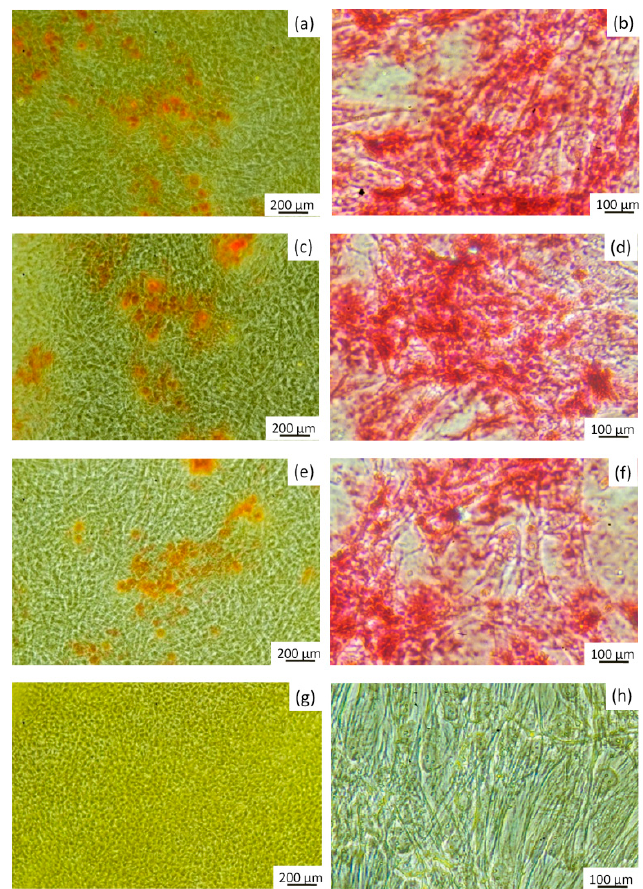
Figure 6. Optical microscopic images taken after staining with Alizarin Red S of ADMSCs cultured in the presence of ( a , b ) 13-93 BG coated Ti, ( c , d ) 13-93-B3 BG coated Ti in osteogenic medium, ( e,f ) positive control and ( g , h ) negative control (ADMSCs cultured with or without osteogenic medium, respectively) for three weeks. The magnification is 20× (on the left) and 40× (on the right).